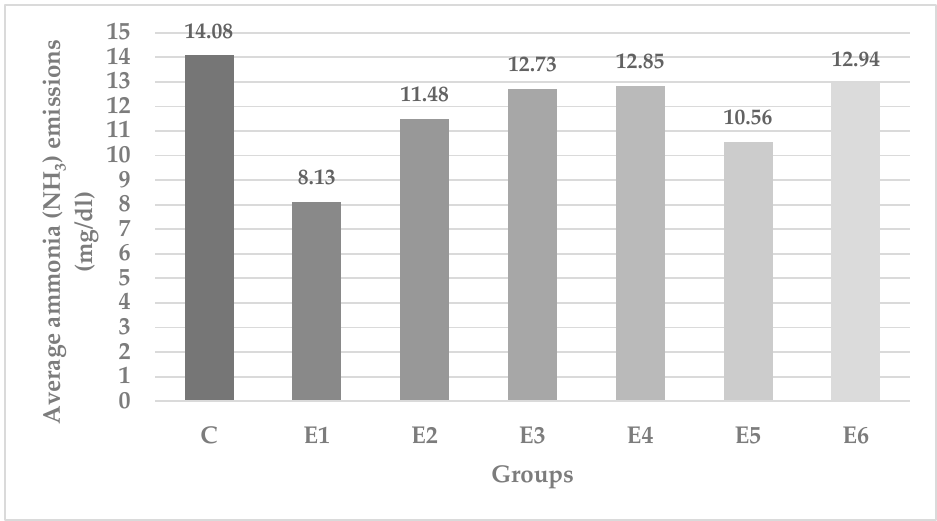
Figure 1. Average ammonia (NH 3 ) emissions from cattle manure during the study period (mg/dL).